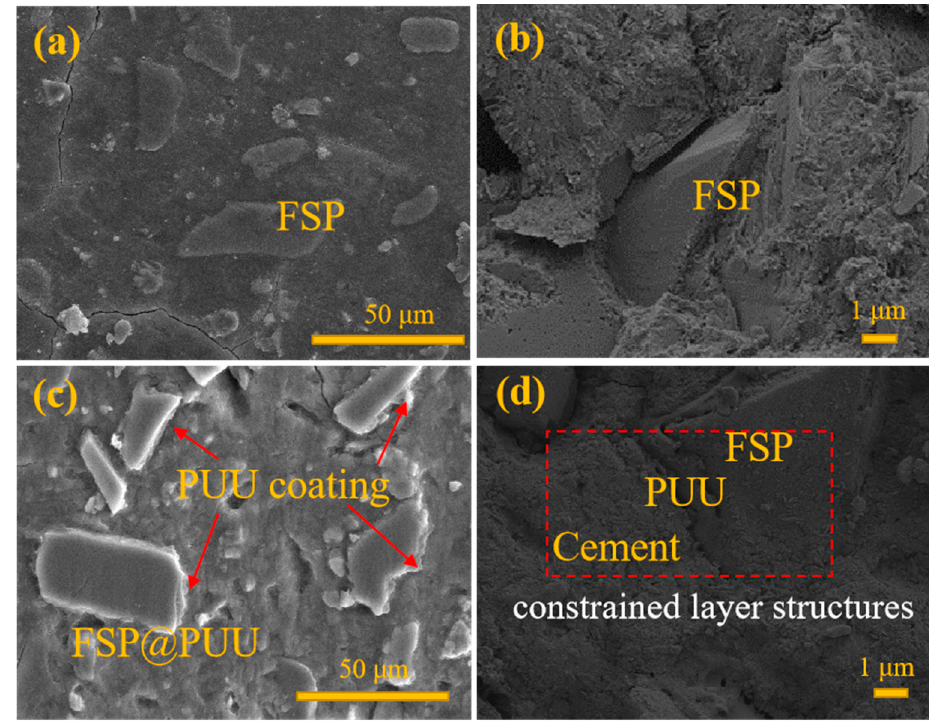
Figure 10. The SEM of cement ( a , b ) and FSP@PUU/ Cement ( c , d ).